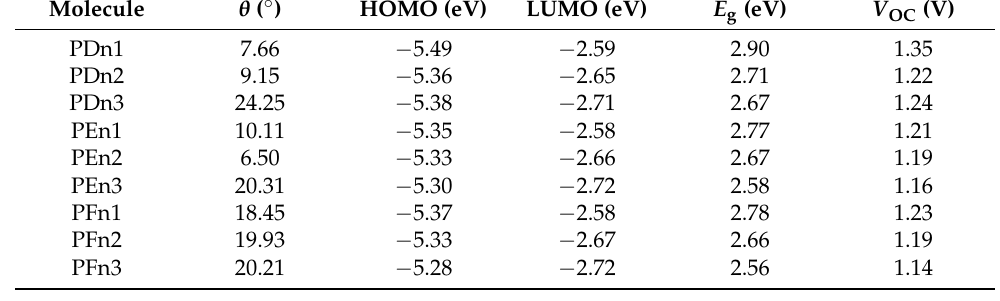
D A E E HOMO LUMO and represent the energy level of HOMO (donor) and LUMO (ac- where